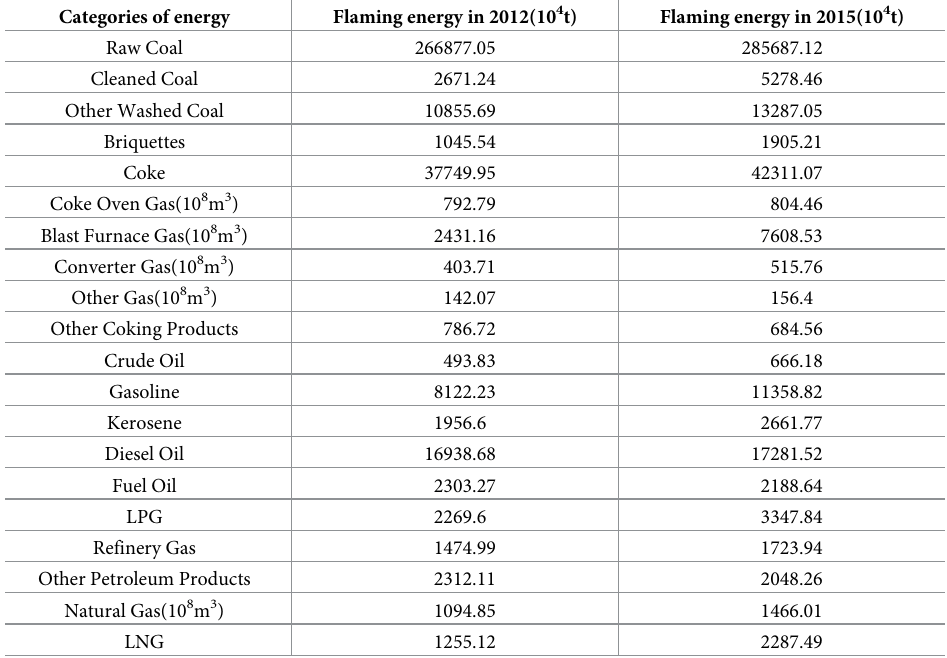
Table 2. Energy use of China in 2012 and 2015.